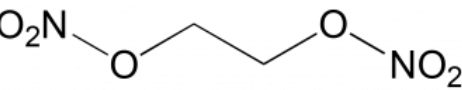
Figure 1. Formula of ethylene glycol dinitrate.